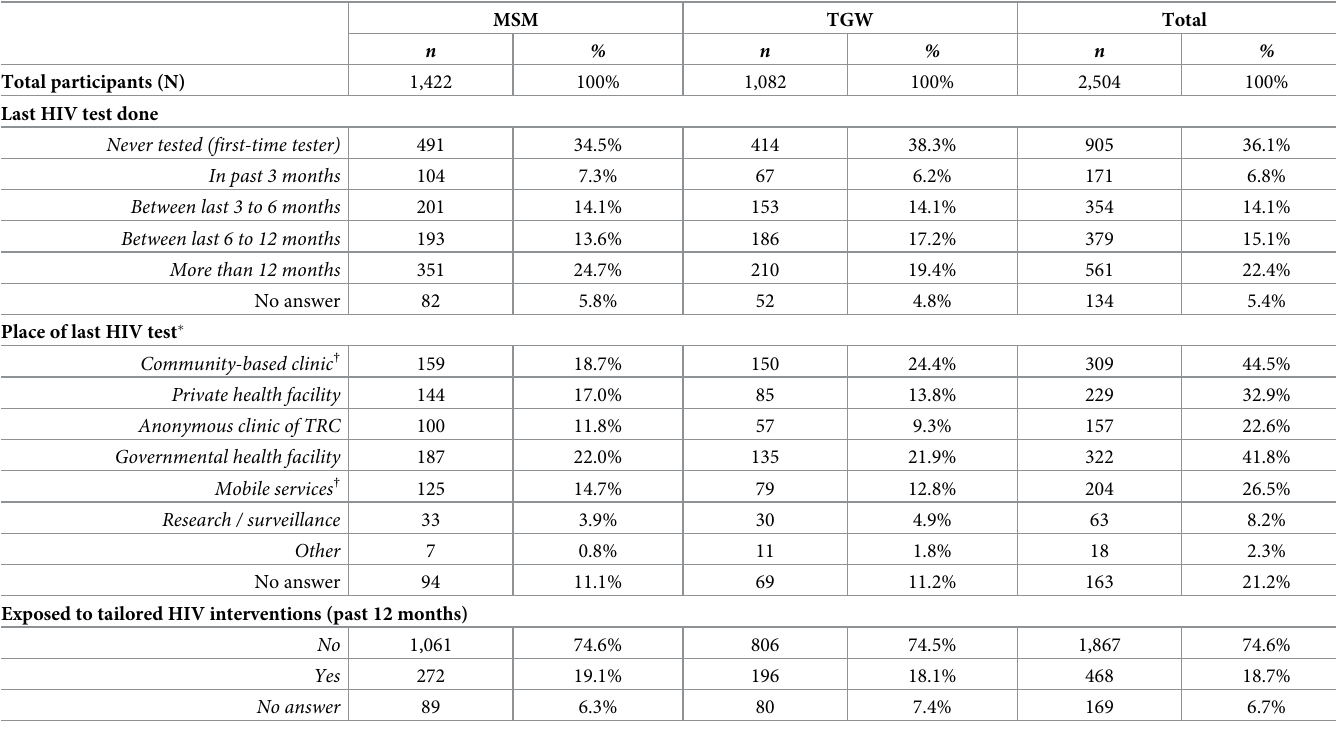
Table 4. Uptake of HIVST by population.